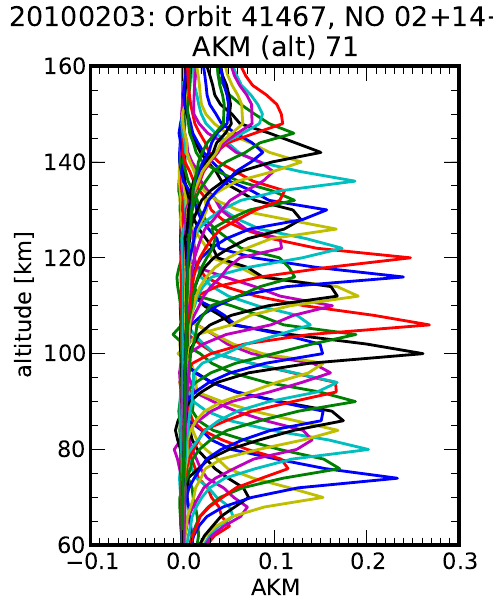
Fig. 6. Altitude averaging kernel matrix elements for a sample orbit (no. 41467, 3 February